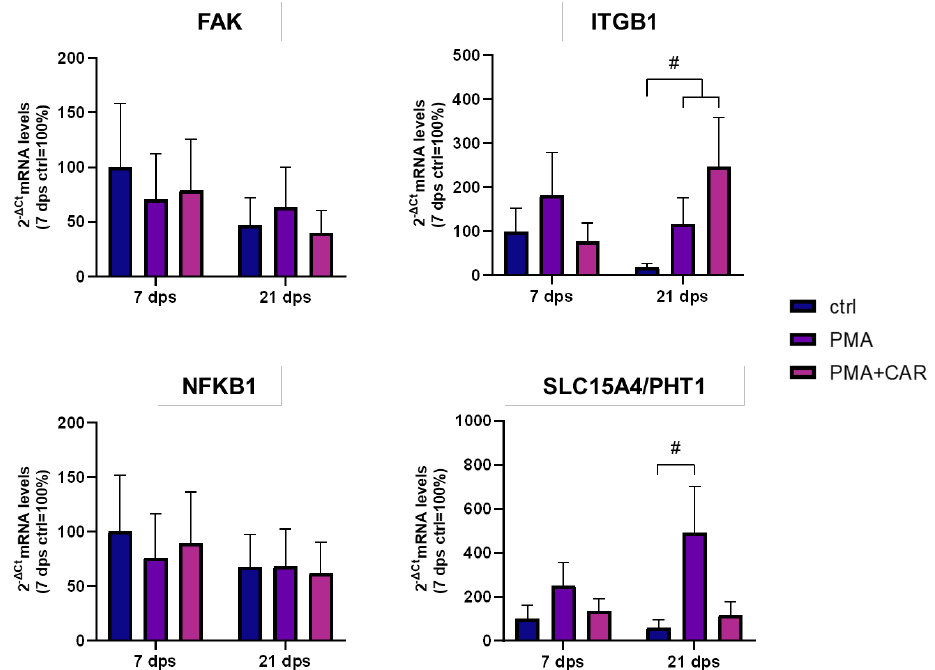
Figure 6. mRNA expression analysis by qPCR of cytoskeleton-/inflammation-related genes in 7 dps and 21 dps Caco-2 monolayer under PMA and PMA+CAR exposure for 48 h. Amounts of detected mRNAs (FAK, ITGB1, NFKB1, SLC15A4/PHT1) were calculated and expressed as 2 - ΔCt mean values obtained from two rounds of real-time PCR (qPCR) assays for each of three independent biological replicates (see Materials and Methods for details) and then were expressed as a percentage with respect to the control mean value at 7 dps (ctrl = 100%). Statistical analysis by one-way ANOVA with Dunnett correction for multiple comparisons (# p ≤ 0.05 vs. control at 21